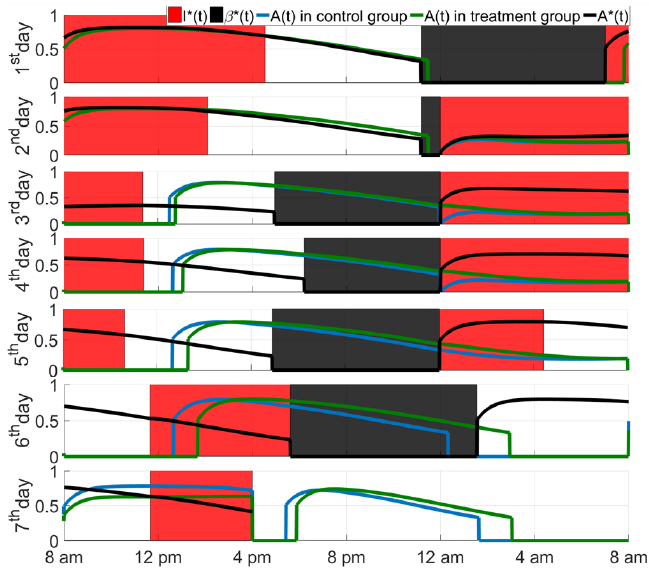
Figure 12. The alertness optimization results in Case3